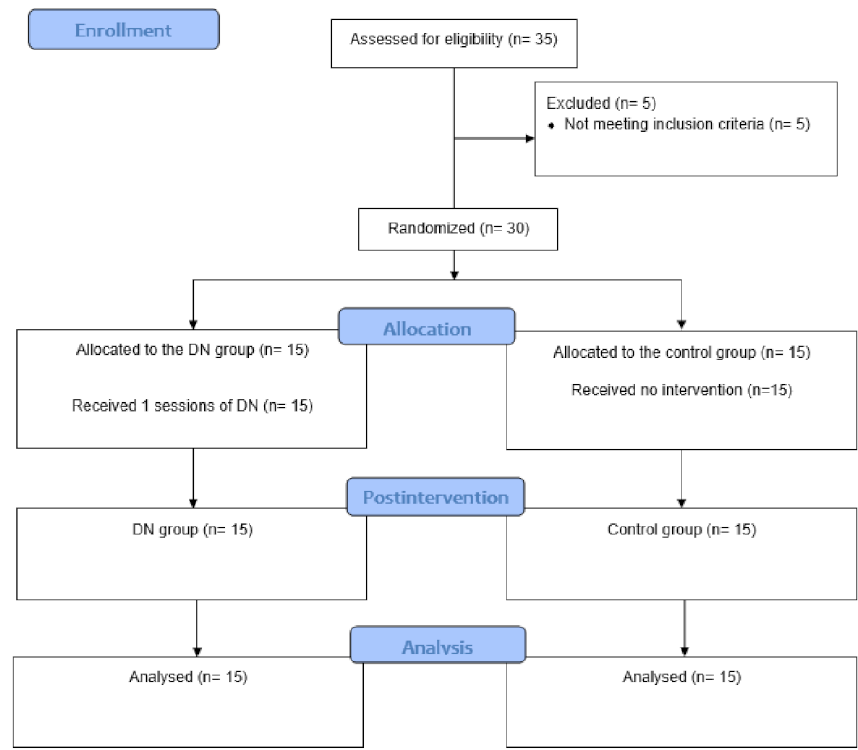
Figure 1. Flowchart diagram.